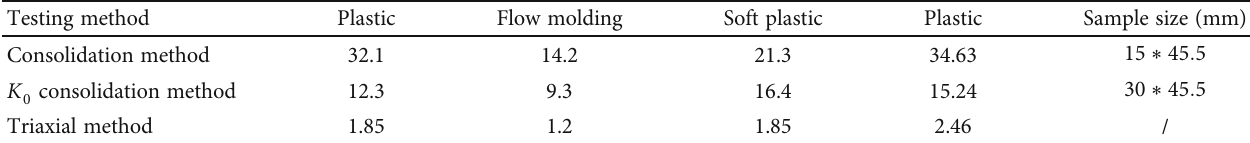
Table 4: Comparison of vertical bed coe ffi cients of di ff erent